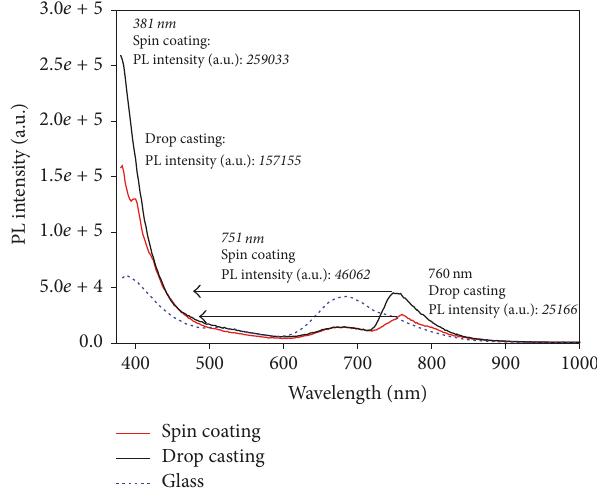
Figure 8: Photoluminescence emission spectra of T12 p-terphenyls deposited by spin coating and drop casting and glass substrate as reference.